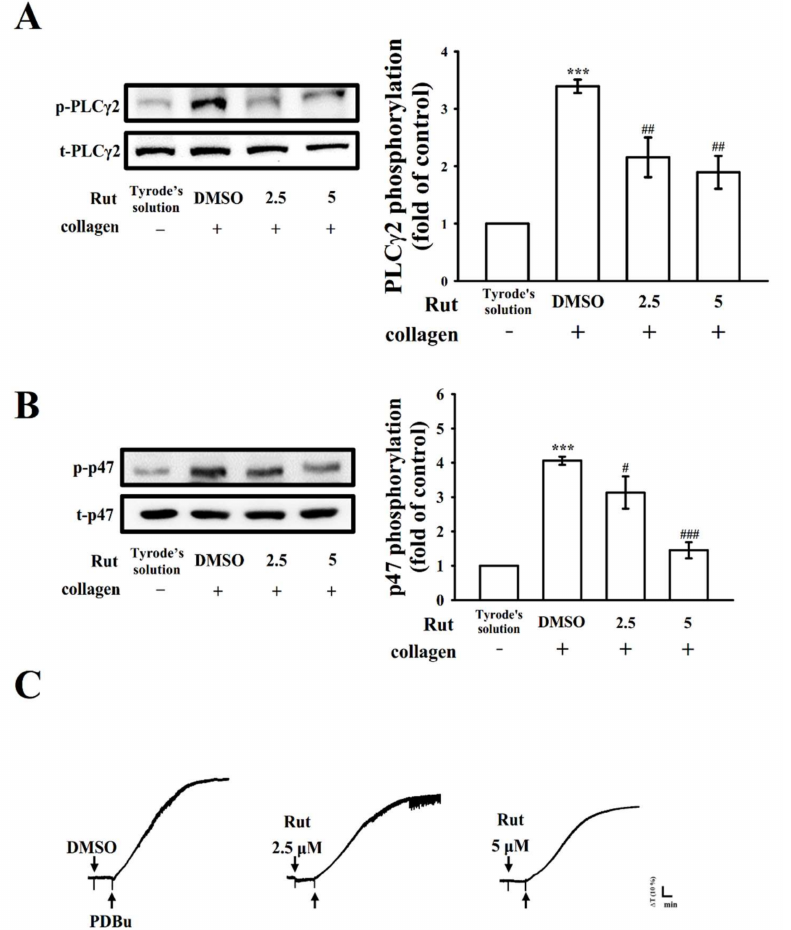
Figure 3. Regulatory effects of Rut on phospholipase C γ 2 (PLC γ 2) and protein kinase C (PKC) activation in platelets. Washed platelets were preincubated with 0.1% DMSO or Rut (2.5 and 5 µ M) and subsequently treated with collagen (1 µ g/mL) or phorbol 12,13-dibutyrate (PDBu, 150 nM) to stimulate either ( A ) PLC γ 2, ( B ) PKC activation (p-p47), or ( C ) platelet aggregation. Data are presented as the mean ± standard error of the mean ( n = 4). *** p <0.001 compared with the resting platelets; # p < 0.05, ## p < 0.01, and ### p < 0.001 compared with the 0.1% DMSO-treated group. Profiles in ( C ) are representative of four independent